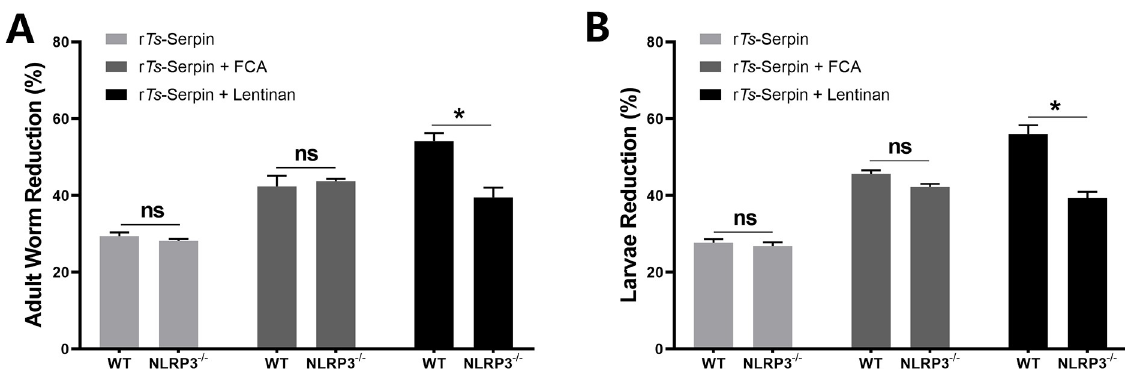
Fig 5. Protective immunity induced by immunizing WT and NLRP3 -/- mice with lentinan against T . spiralis . The adult worms (A) and muscle larvae (B) reduction rates were analyzed based on the the mean number of adult worms or the recovered muscle larvae per gram (LPG) of muscle from vaccinated groups compared with PBS group from immunized WT and NLRP3 -/- mice after challenge with 500 ML of T . spiralis . Results are expressed as the mean ± SD of 10 mice per group. The data shown are representative of three independent experiments. � p < 0.05 vs the as indicated by the line (Tukey multiple comparison following ANOVA).